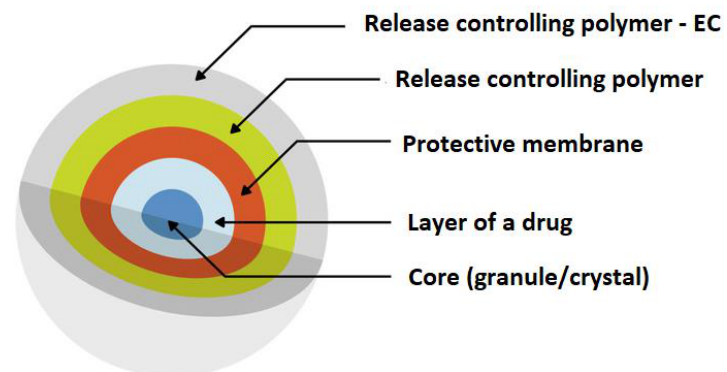
Figure 8. Scheme illustration of SODAS ® delivery system modified from Elan drug technologies [39]. Reprinted with permission from Reference [16]. Copyright 2019 MDPI.